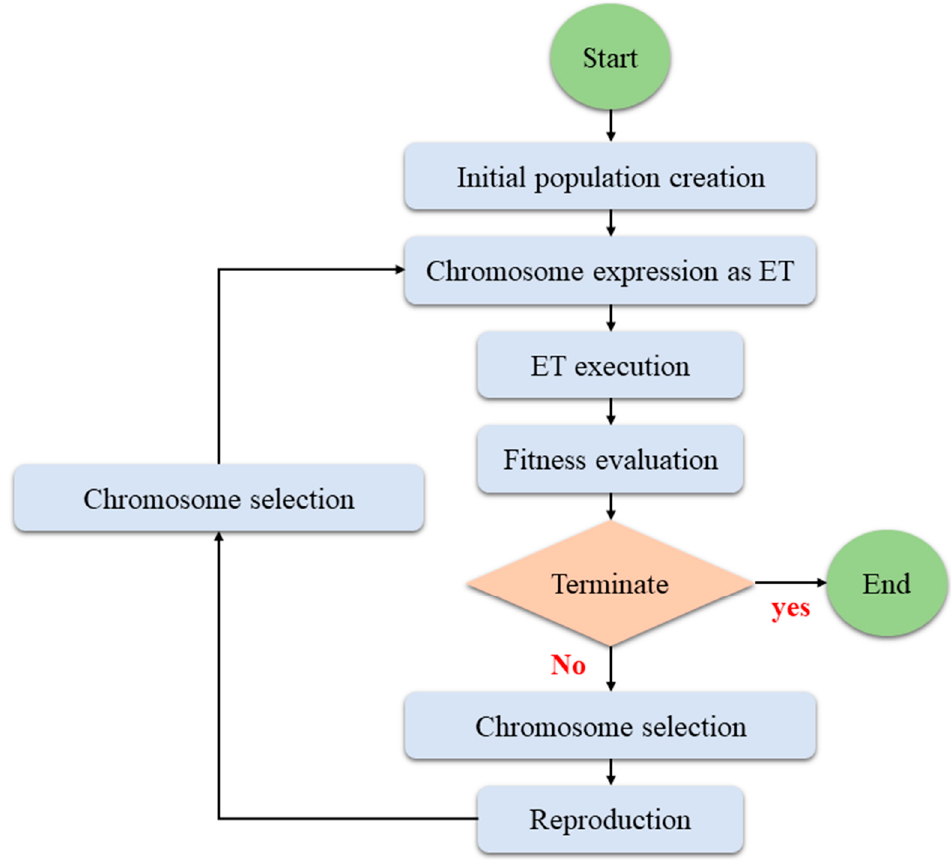
Figure 1. A flowchart of the GEP steps.